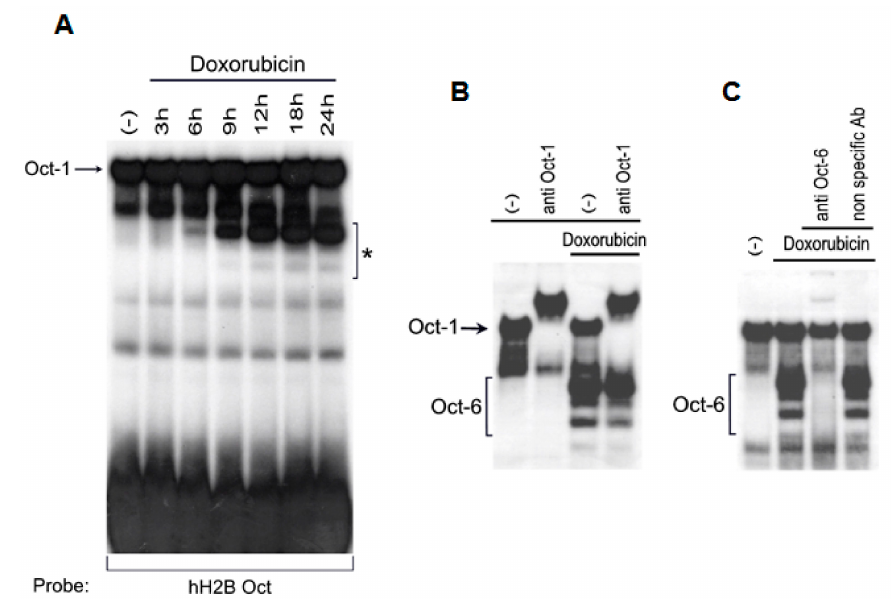
Figure 1. Doxorubicin (Dox) induces octamer DNA binding complexes in H460 cells. An electrophoretic mobility-shift assay (EMSA) was performed using the hH2B-octamer (Oct) sequence as a